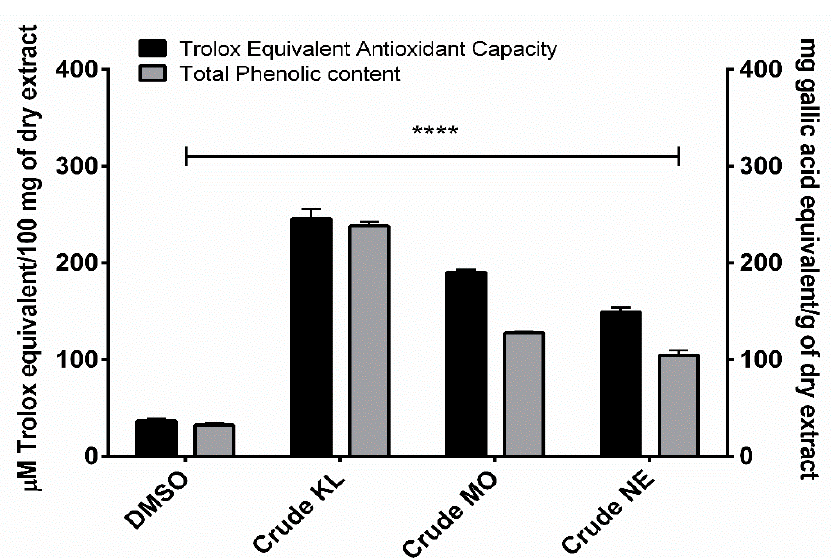
Figure 1. Trolox equivalent antioxidant capacity and total phenolic content of Citrus hystrix DC. (KL), Moringa oleifera Lam. (MO) and Azadirachta indica A. Juss. (NE) crude leaf ethanolic extracts. Results are expressed as Trolox equivalent (µM) and gallic acid equivalent (mg) for antioxidant and total phenolic contents, respectively. Data are presented as mean ± SD. * p < 0.05; ** p < 0.01; *** p < 0.001; **** p < 0.0001 compared to DMSO: dimethyl sulfoxide.